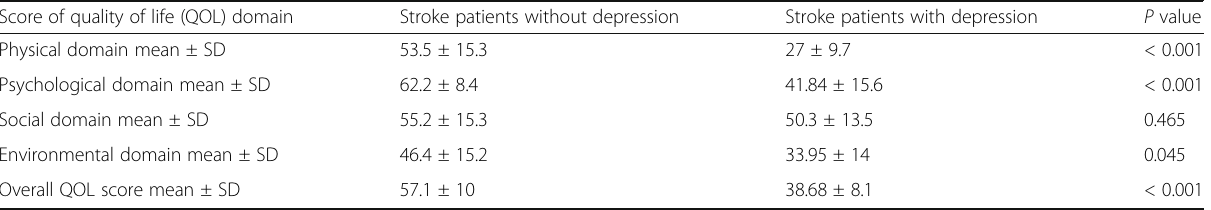
Table 5 Quality of life and state of functioning among stroke patients groups (with versus without depression) Score of quality of life (QOL) domain Stroke patients without depression Stroke patients with depression P value Physical domain mean ± SD 53.5 ±